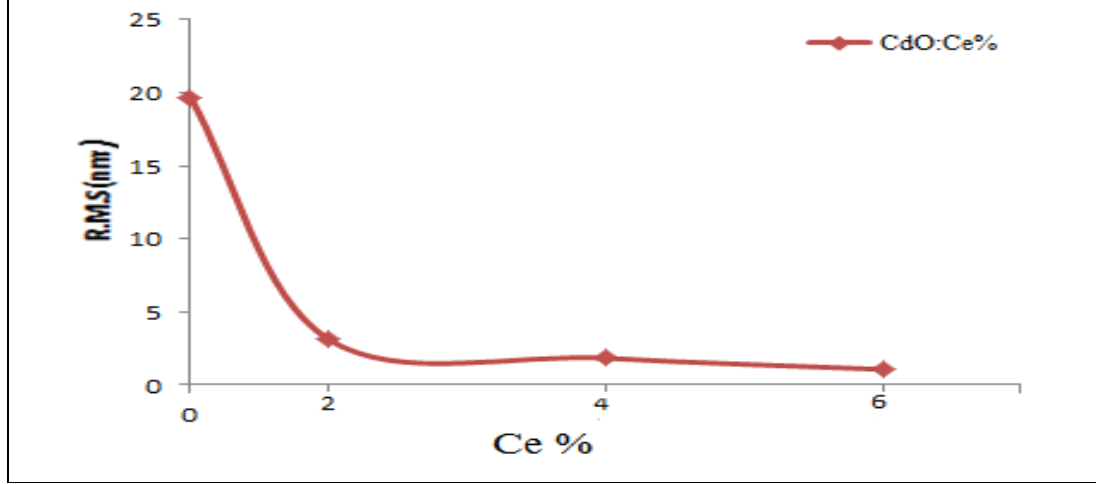
Fig. 6: Variation of Root mean square with Ce concentration for CdO prepared glass substrates.